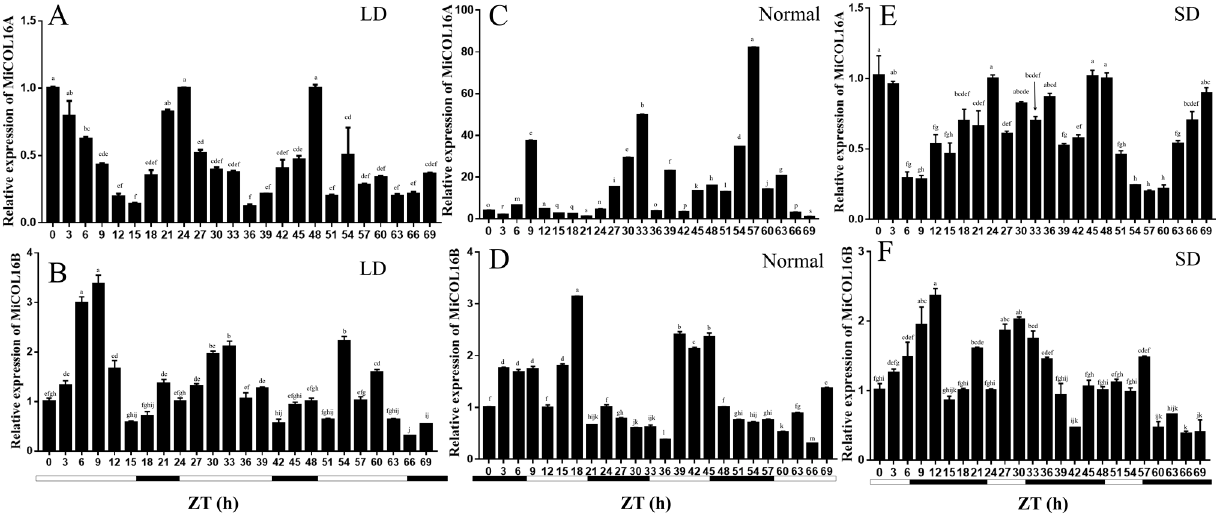
Figure 3. Expression analysis of the MiCOL16A and MiCOL16B genes in terms of circadian rhythm. ( A , C , E ) Expression patterns of MiCOL16A under LD ( A ), normal ( C ) and SD ( E ) conditions. ( B , D , F ) Expression patterns of MiCOL16B under LD ( B ), normal ( D ) and SD ( F ) conditions.